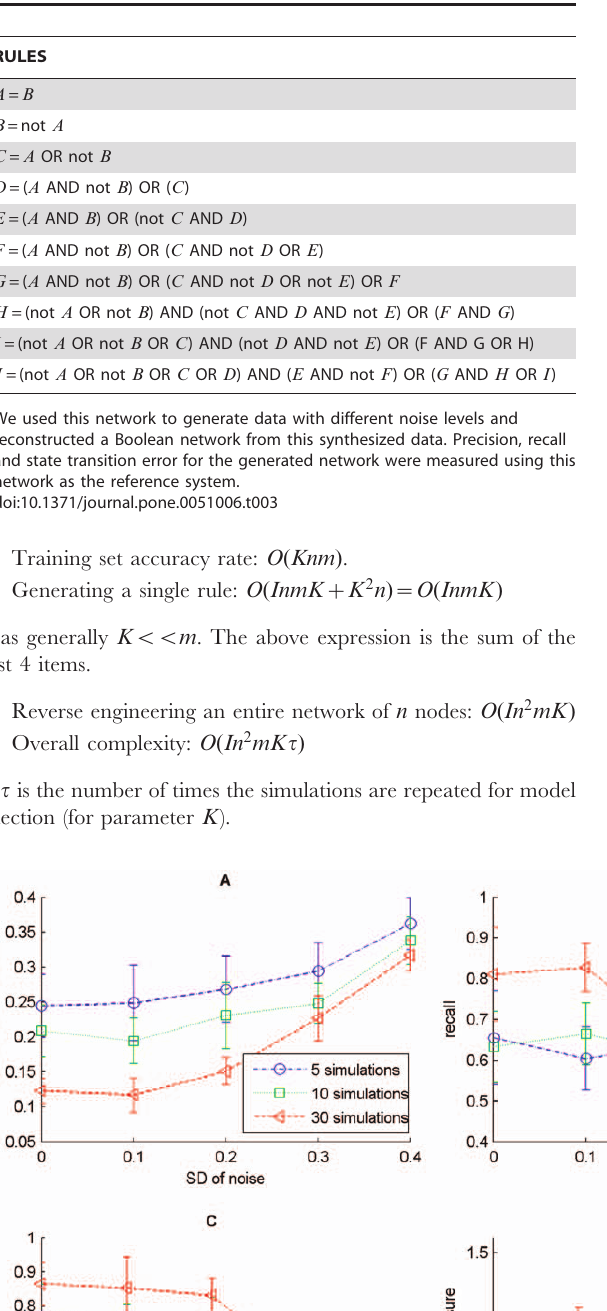
Table 3. Network with 10 nodes, having varying